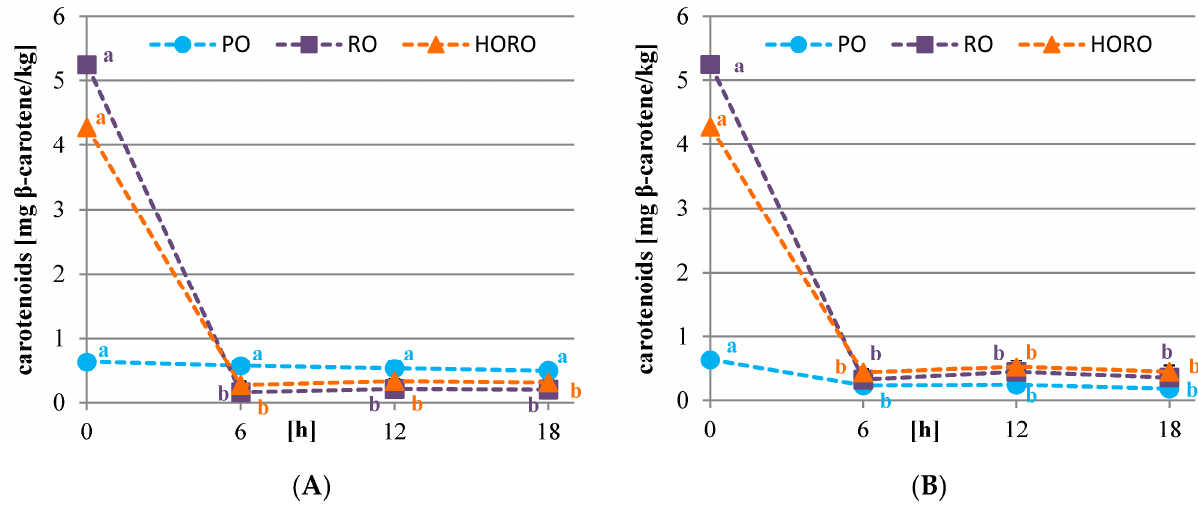
Figure 3. Changes in the content of carotenoid pigments [mg β -carotene/kg oil] of tested oils during deep frying of potatoes ( A ) or tofu ( B ). PO—palm olein; RO—cold pressed rapeseed oil; HORO—cold pressed high oleic rapeseed oil. The values for the specific oil with different letters (a, b) are significantly different ( p < 0.05).